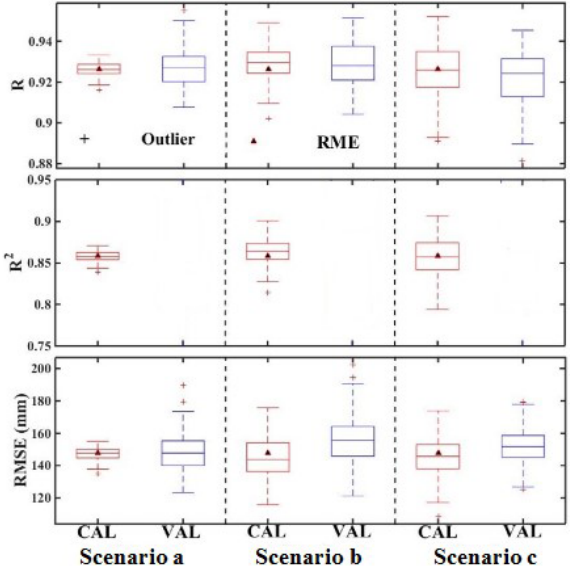
Figure 4. Box plots of R , R 2 , and E RMS of the RME model under three scenarios: (a) fully random; (b) all gauges, partial period; and (c) partial gauges, entire period. Details of the three scenarios refer to Sect. 2.2. The triangle marker corresponds to the value ( R , R 2 , RMSE) of the RME model. Plus signs represent the outlier of the sample used to draw the box diagram whose value is out of the range from (Q1 − 1.5IQR) to (Q3 + 1.5IQR). Q1 and Q3 represent the lower and upper quartiles, IQR =